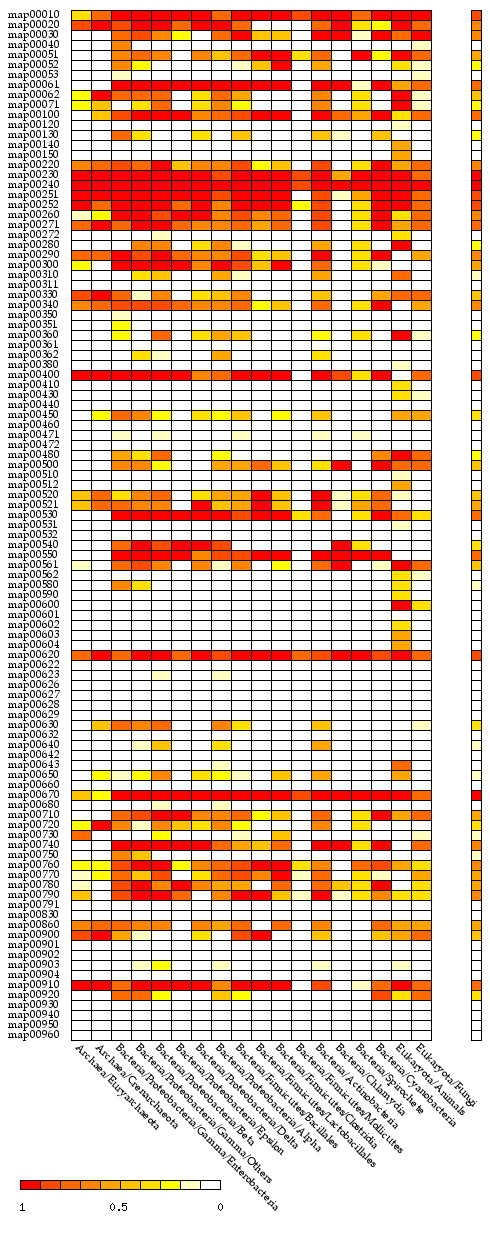
The distribution of pathway specific organisms in different phylogenetic categories. The grid color indicates the fraction of organisms in each category containing a certain pathway. The definition of presence or absence of metabolic pathways is given in Methods.